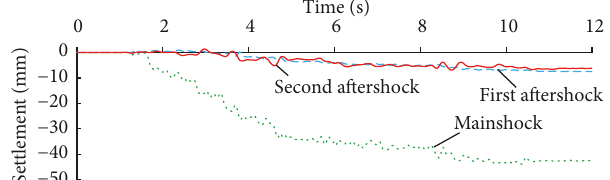
Figure 11: Settlement of the soil surface during the mainshock and